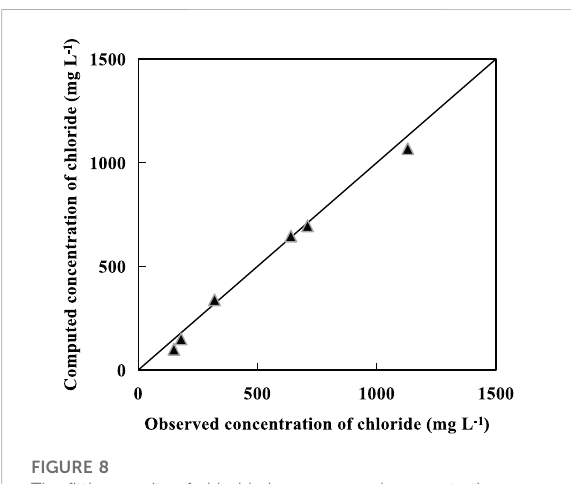
FIGURE 8 The fi tting results of chloride ions measured concentration and calculated